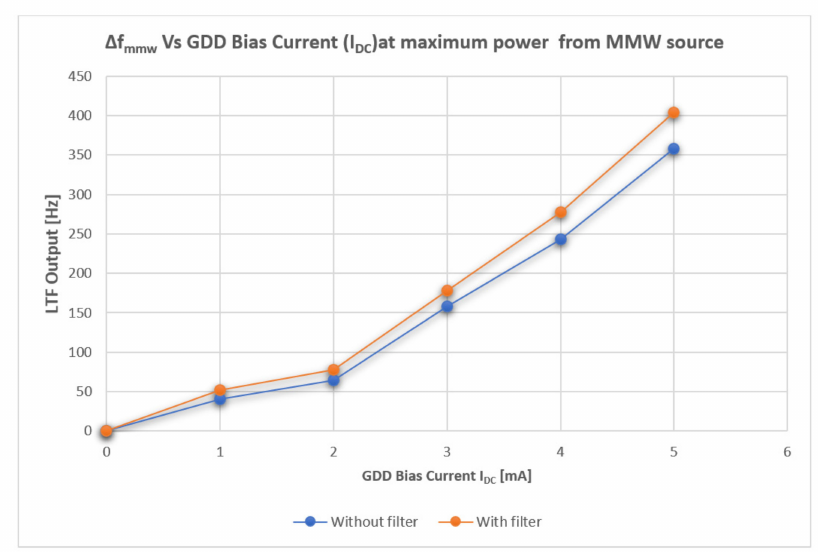
Figure 7. LTF output ∆ f mmw as a function of GDD bias current (I DC